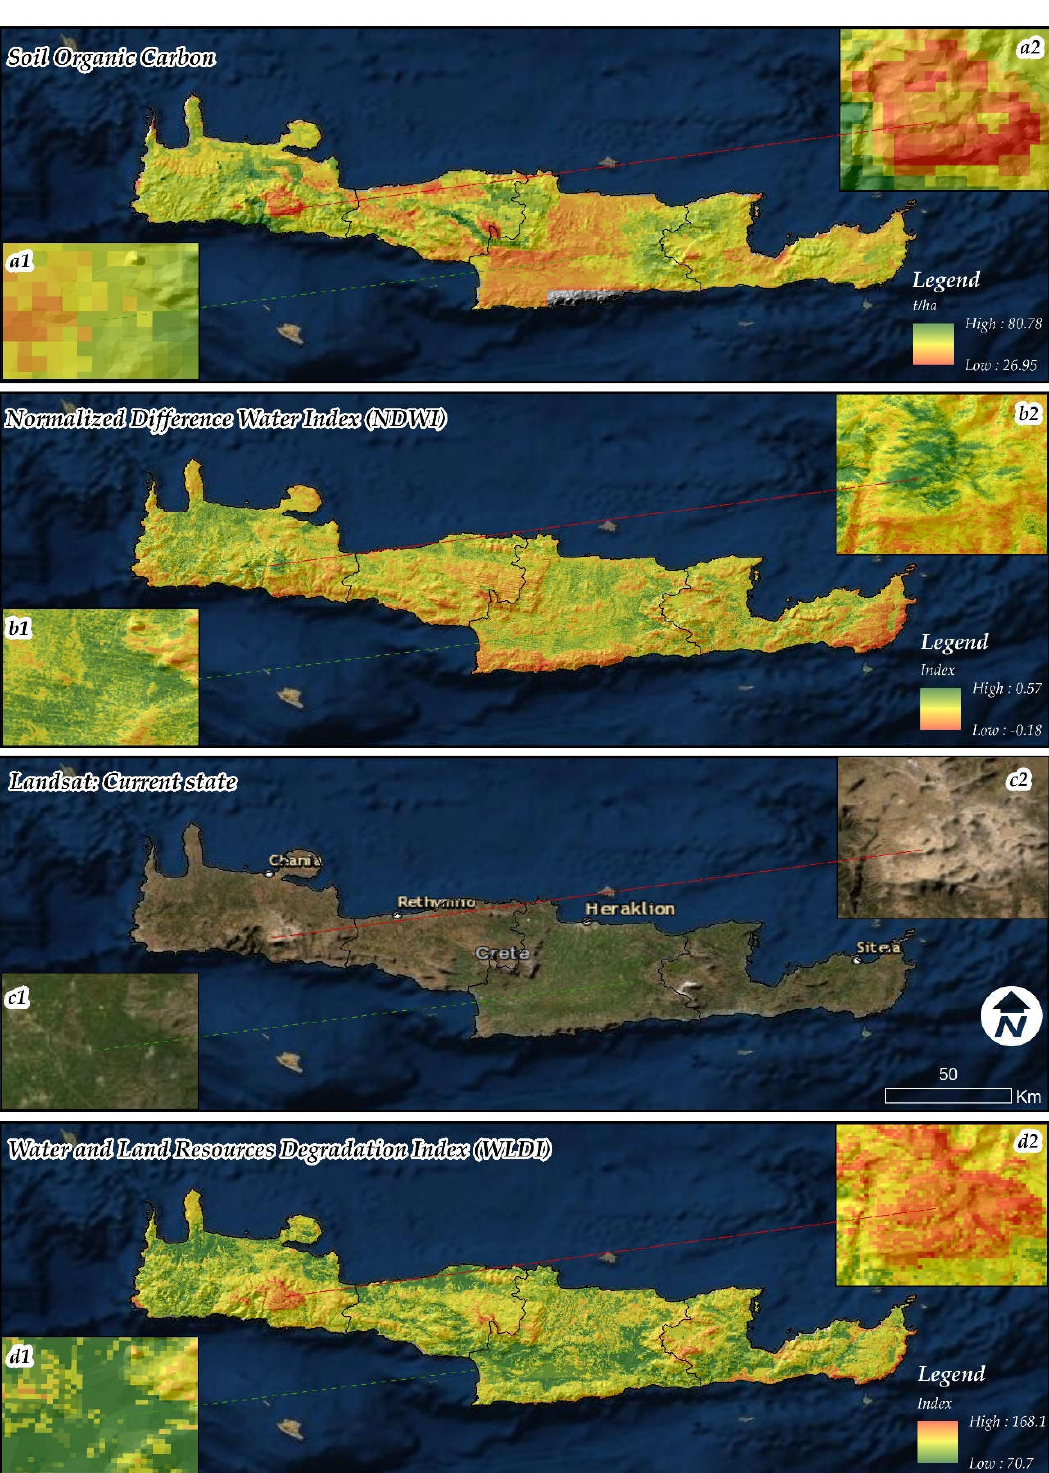
Figure 3. SOC, NDWI, WLDI and Landsat maps in Crete Island. ( a1 ) Spots with low values of Soil Organic, ( a2 ) spots with high values of Soil Organic ( b1 ), spots with low values of Normalized Difference Water Index, ( b2 ) spots with high values of Normalized Difference Water Index, ( c1 , c2 ) spots with low values of Landsat current state, ( d1 ) spots with low values of Water and Land Degradation Index and ( d2 ) spots with high values of Water and Land Degradation Index.